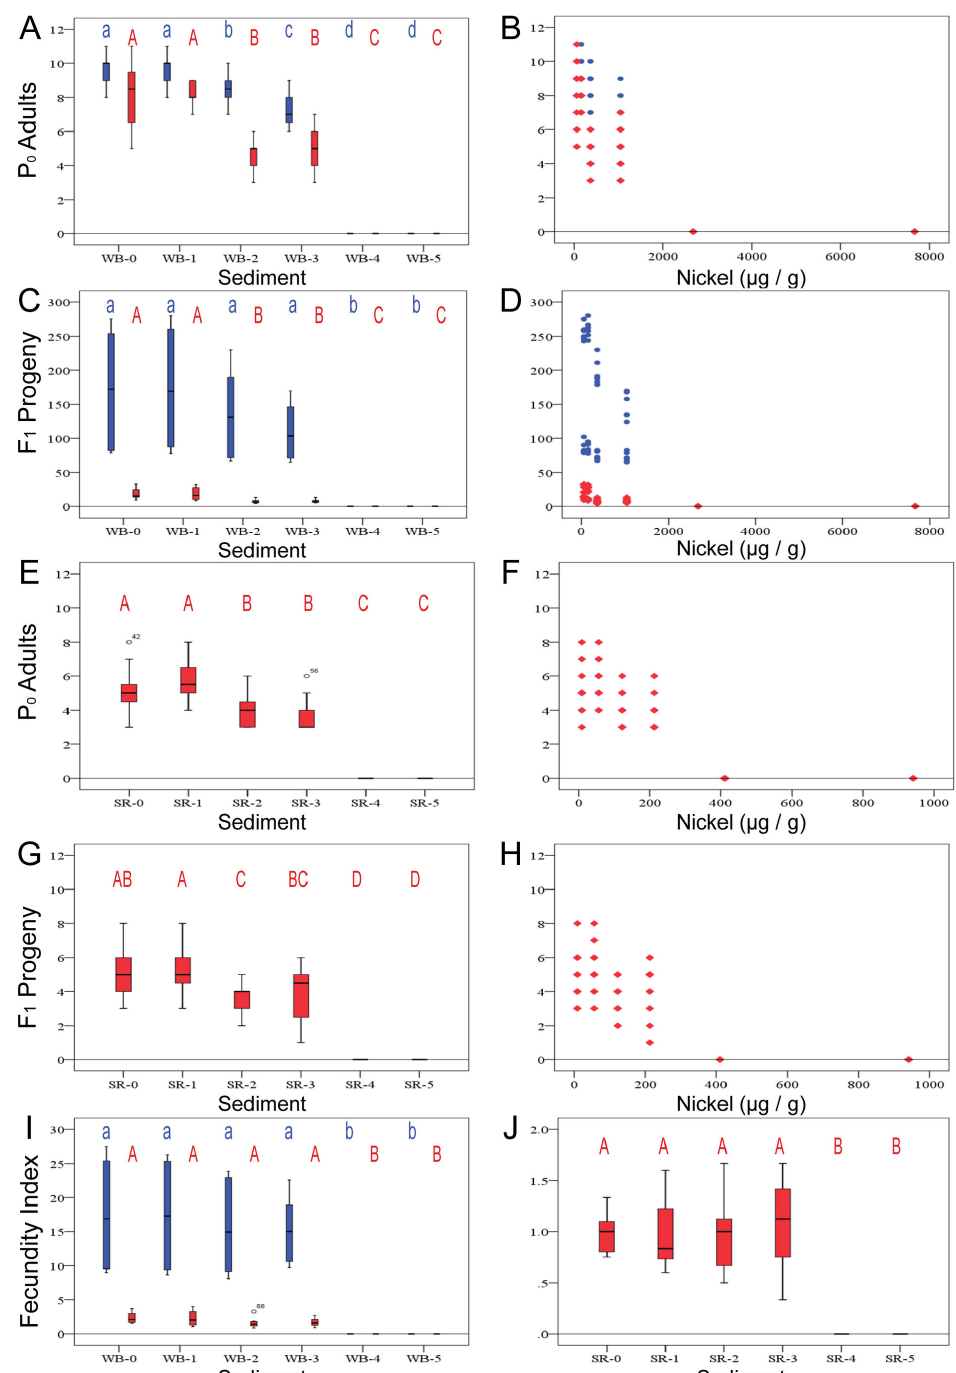
Figure 4. Recovery of P0 adult nematodes and F1 progeny from nickel-spiked sediments (i.e. WB-0 through WB-5 and SR-0 through SR-5). Box-and-whisker plots are formatted and labeled as in Figure 3. Scatterplots: P0 recovery for individual wells plotted against sediment nickel concentration. Blue circles, C. elegans ; red diamonds, P. pacificus . (A-D, I) WB Ni(II)-spiked sediment series. (A) P0 recovery and sediment treatment. (B) P0 recovery and sediment nickel concentration. (C) F1 recovery and sediment treatment. (D) F1 recovery and sediment nickel concentration. (E-H, J) SR Ni(II)-spiked sediment series. (E) P0 recovery and sediment treatment. (F) P0 recovery and sediment nickel concentration. (G) F1 recovery and sediment treatment. (H) F1 recovery and sediment nickel concentration. (I and J) Fecundity ratio and sediment treatment. doi: 10.1371/journal.pone.0077079.g004 PLOS ONE |